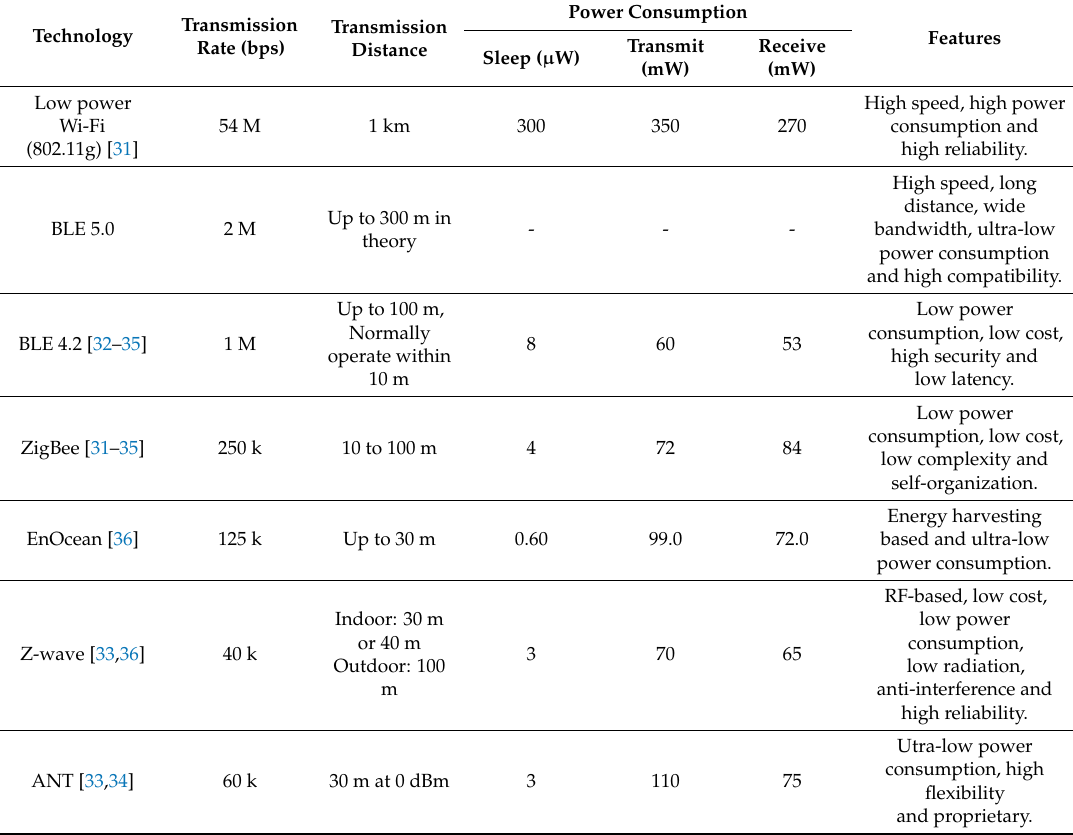
Table 1. Comparison of traditional wireless transmission